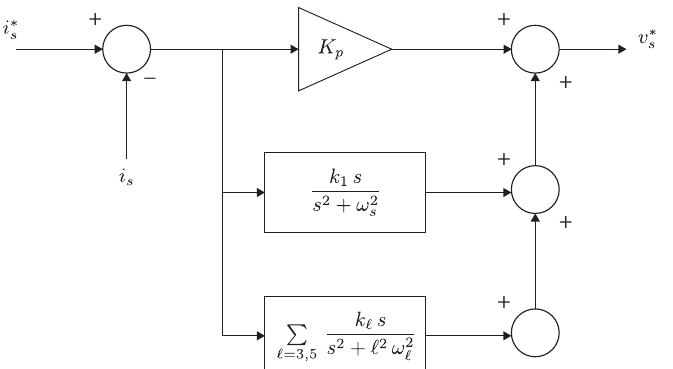
Figure 7. Proportional multi-resonant (PMR) load current control loop implementation.